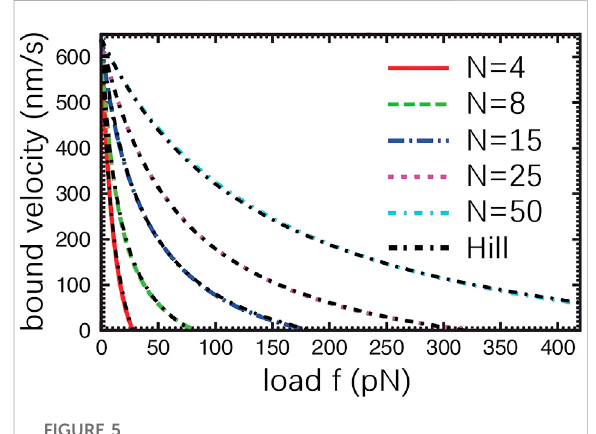
Force-Velocity relationship derived from PCM (Erdmann et al., 2013). f indicates the external force acting on the myosin ensemble. N represents the total number of myosin in the ensemble. The black, dashed curve denotes the result obtained from the Hill muscle